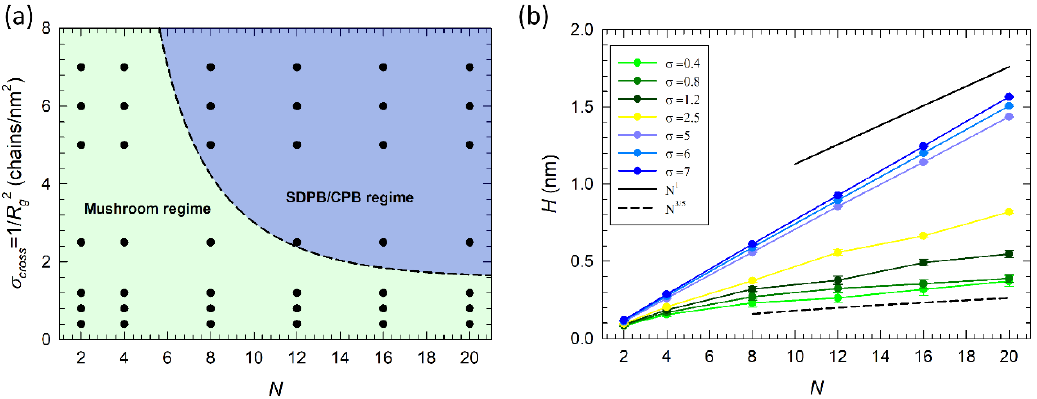
Figure 2. Scaling behavior of alkyl amine brushes grafted to a PEG/PEI surface. ( a ) Crossover grafting density σ cross from mushroom (green filled area) to semi-dilute polymer brush (SDPB) regime (blue filled area) as a function of the grafted chain length N . Black points denote systems considered in this study. ( b ) Scaling behavior of the brush height H as a function of N for all grafting densities considered in this study. A black solid line indicates scaling of the brush in SDPB regime, as H ( N , σ ) ∝ N 1 , and a black dashed line indicates scaling in mushroom regime, H ( N ) ∝ N 3/5 .